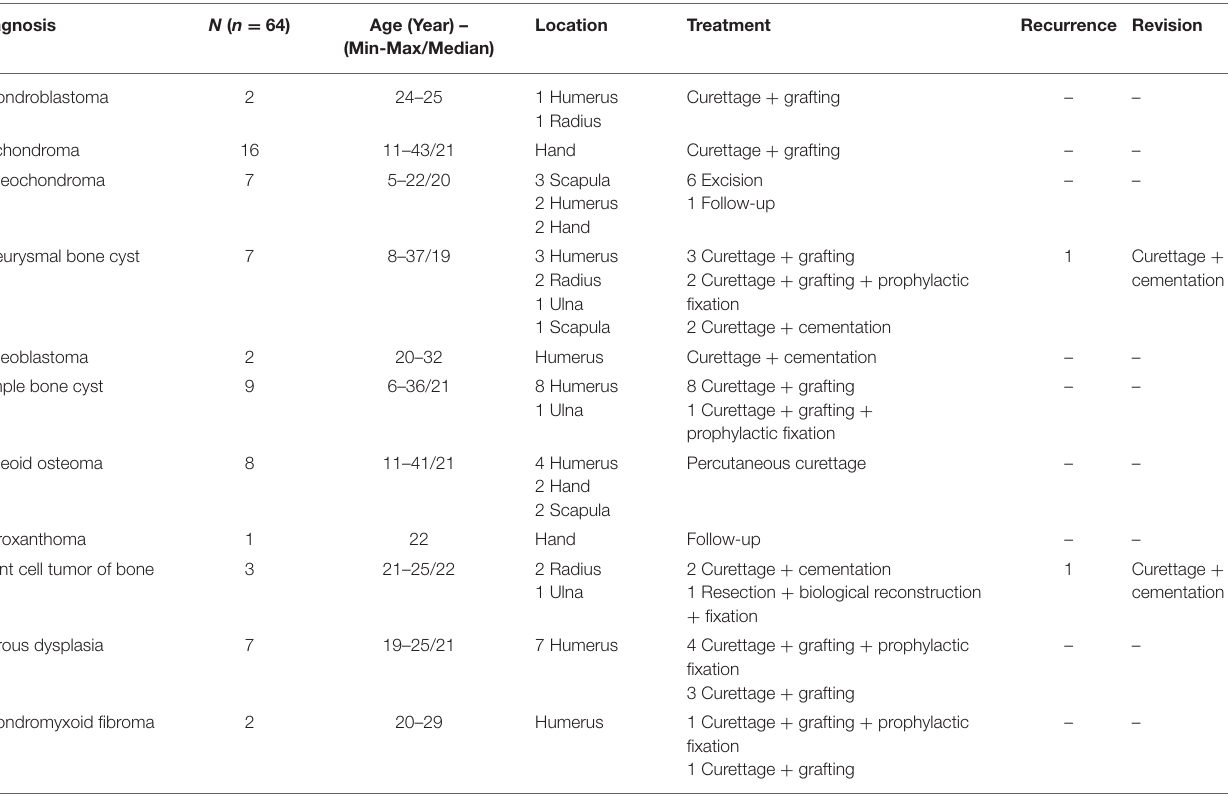
TABLE 4 | Benign bone tumors of the upper extremity.